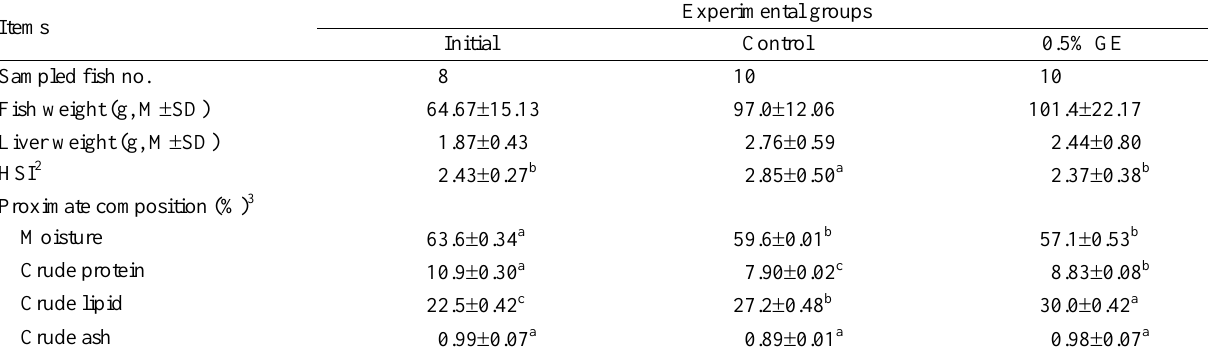
1 Values (means  SE) with different superscripts in the same row indicate significant difference (p<0.05). 2 Hepatosomatic index; (liver weigh (g)  100/body weight (g)). 3 Values are means  SE of 3 replicates with 2 determinations of each replicate